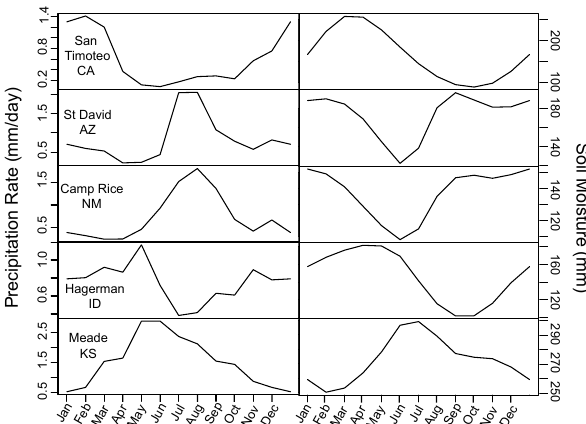
Fig. 2. Average monthly precipitation rates (right) and soil moisture (left) at each site. Precipitation data calculated from CMAP 1979– 2000 (ref. in Fig. 1) and soil moisture calculated from from NOAA Climate Prediction Center 1971–2000 (van den Dool et al., 2003) at each of the isotope